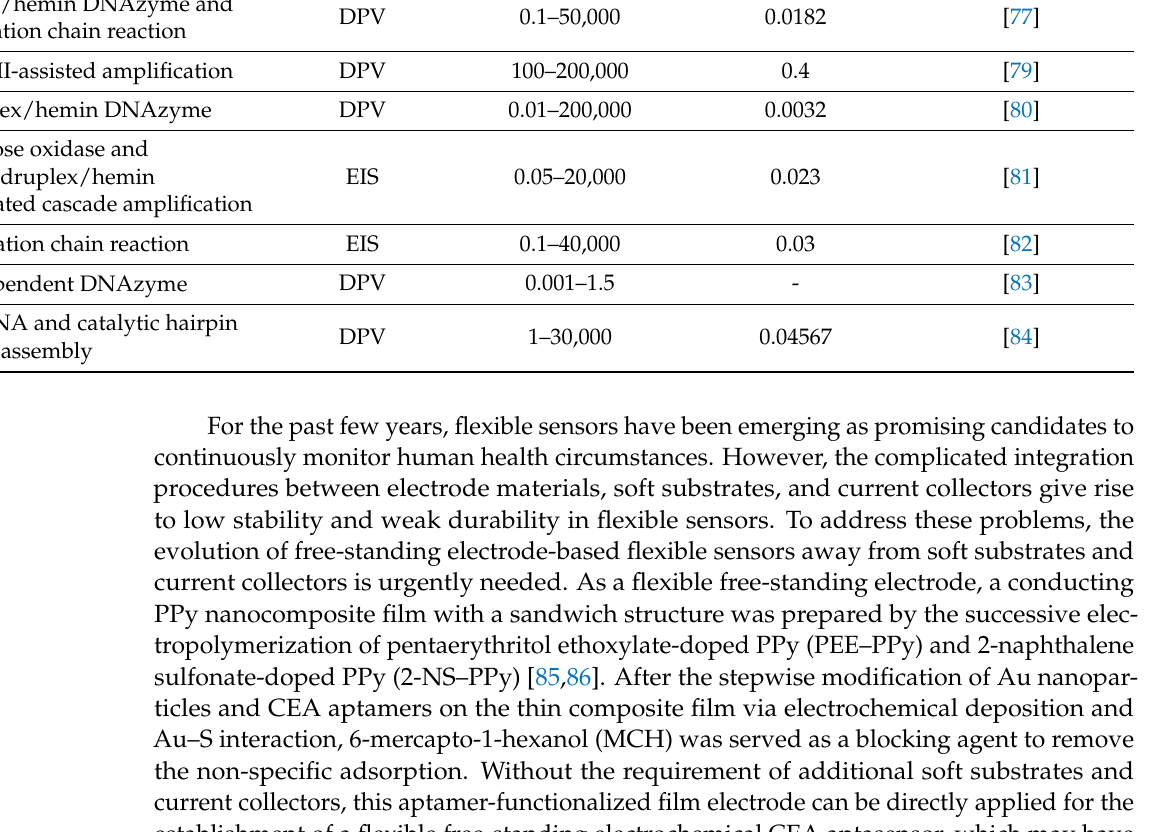
Detection Linear Range Detection Technique (pg mL − 1 )